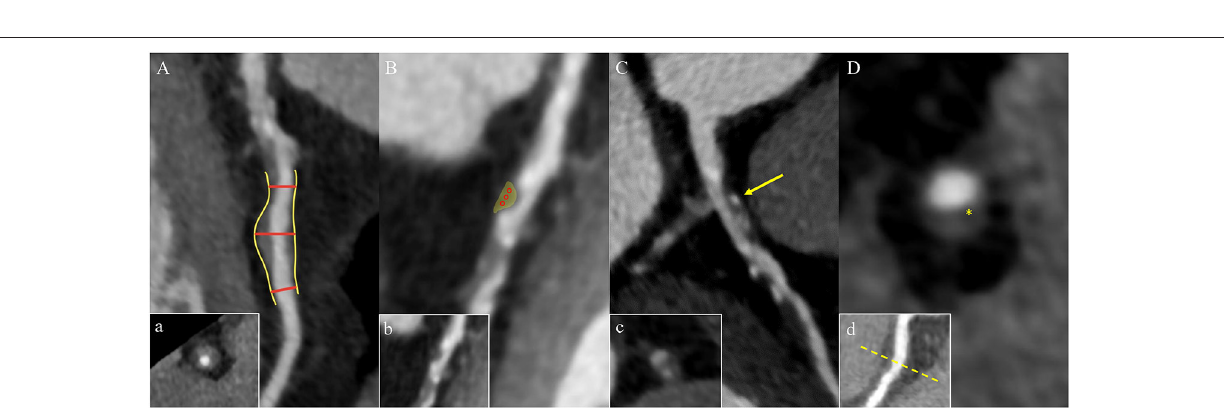
thickness, tube voltage, and so on. Therefore, the current research mainly relies on special procedures to identify which plaque